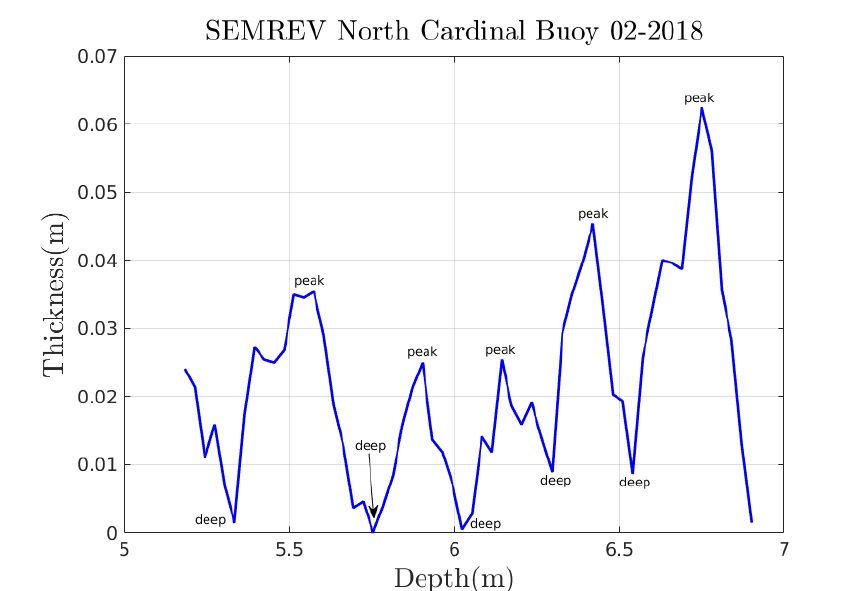
Figure A3. One trajectory on the mooring line of the North cardinal buoy in February 2018.